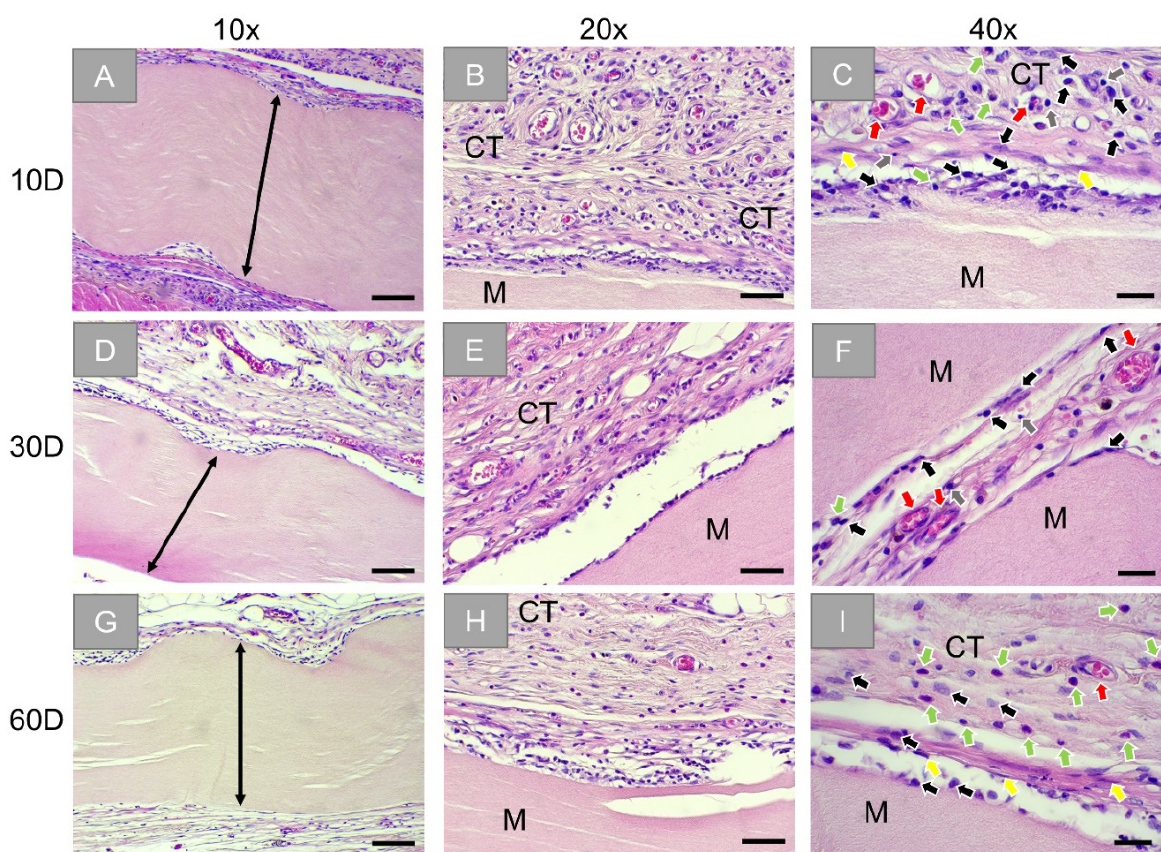
Figure 2. Exemplary histological images of the subcutaneously implanted collagen-based sugar-crosslinked barrier mem- brane (Ossix ® Plus) at three time points: 10 days (first row: ( A – C )), 30 days (second row: ( D – F )), and 60 days (third row: ( G – I )). Stretched black arrow: compact layer of the membrane and M: membrane, CT: connective tissue, black arrows: macrophages, red arrows: blood vessels, green arrows: granulocytes, grey arrows: lymphocytes, yellow arrows: fibro- blasts. (HE-stainings, 10×, 20×, and 40× objective magnifications with scale bars: 100 µm, 50 µm, and 20 µm, respectively).